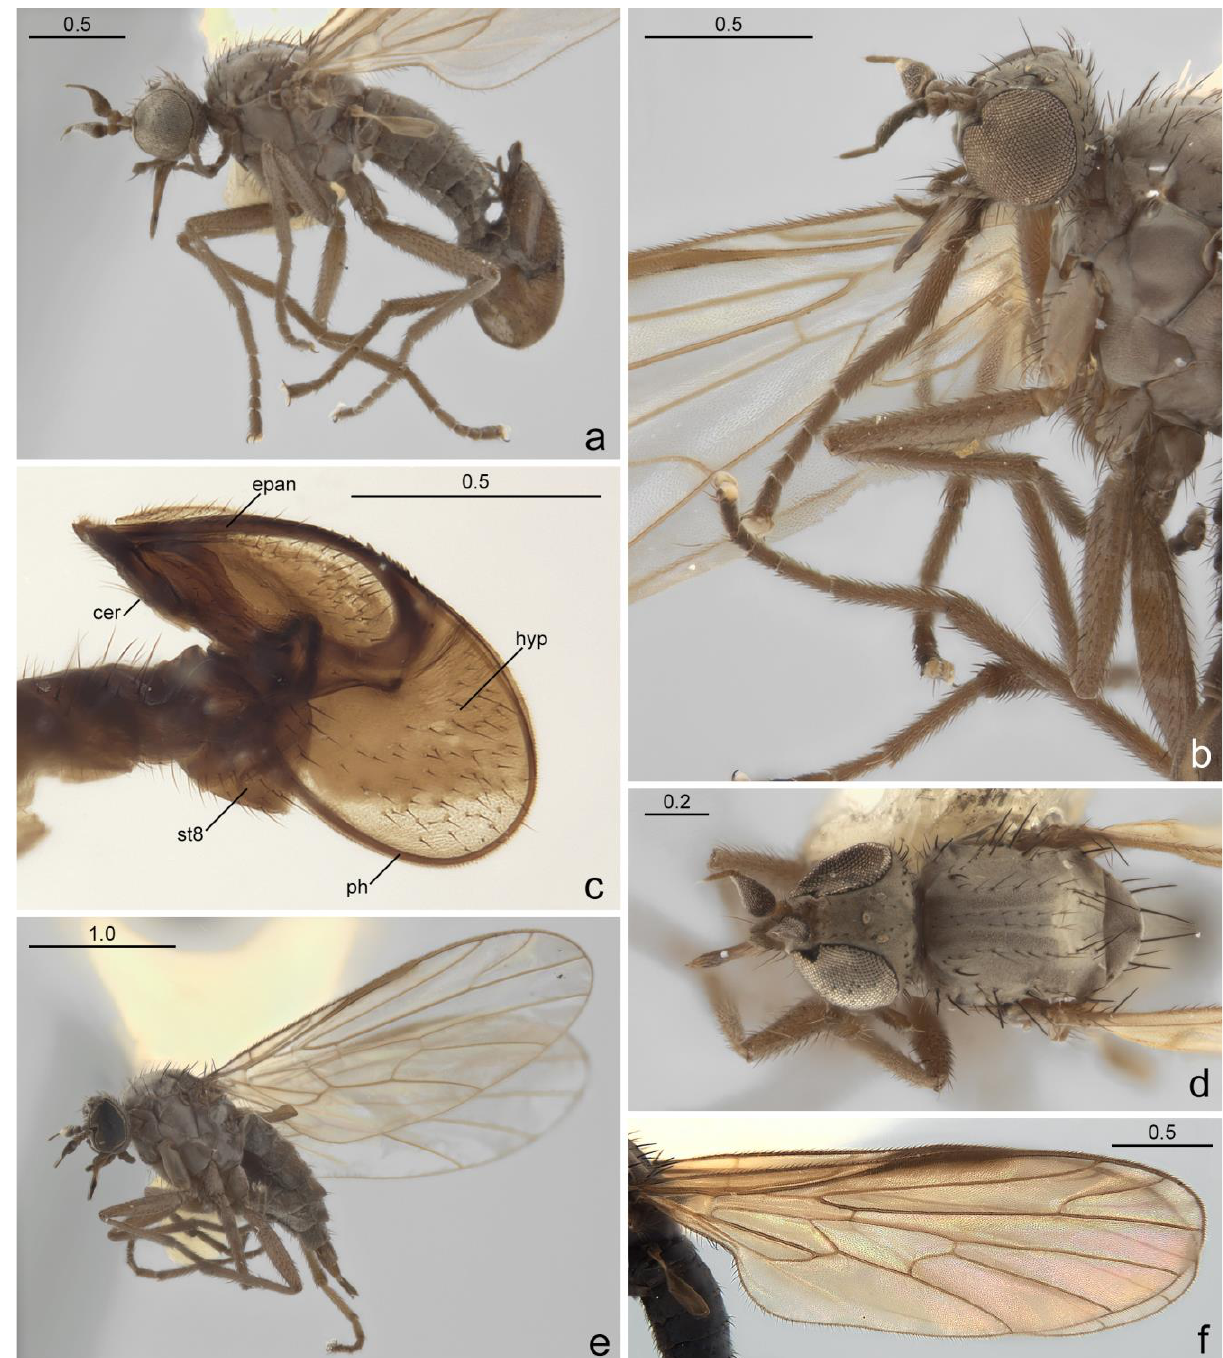
Figure 2. Hilara ranui n. sp.: ( a ) male habitus, left lateral; ( b ) male head, wing base, and legs, left lateral; ( c ) male postabdomen, left lateral; ( d ) male head and thorax, anterodorsal; ( e ) female habitus, left lateral; ( f ) male wing, dorsal. Legend: cer, cercus; sur, surstylus; el, epan, epandrium; hyp, hypandrium; ph, phallus; st 8, sternite 8.